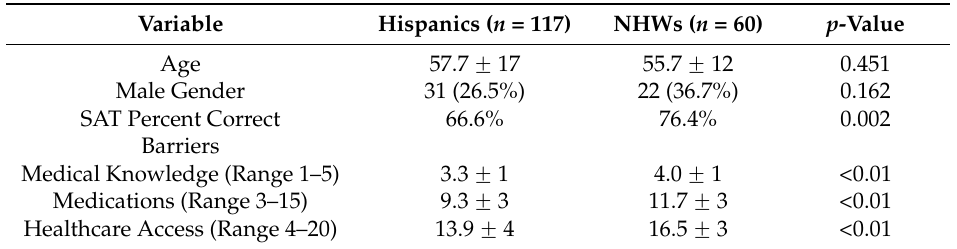
Table 3. Demographics and survey results for general public survey